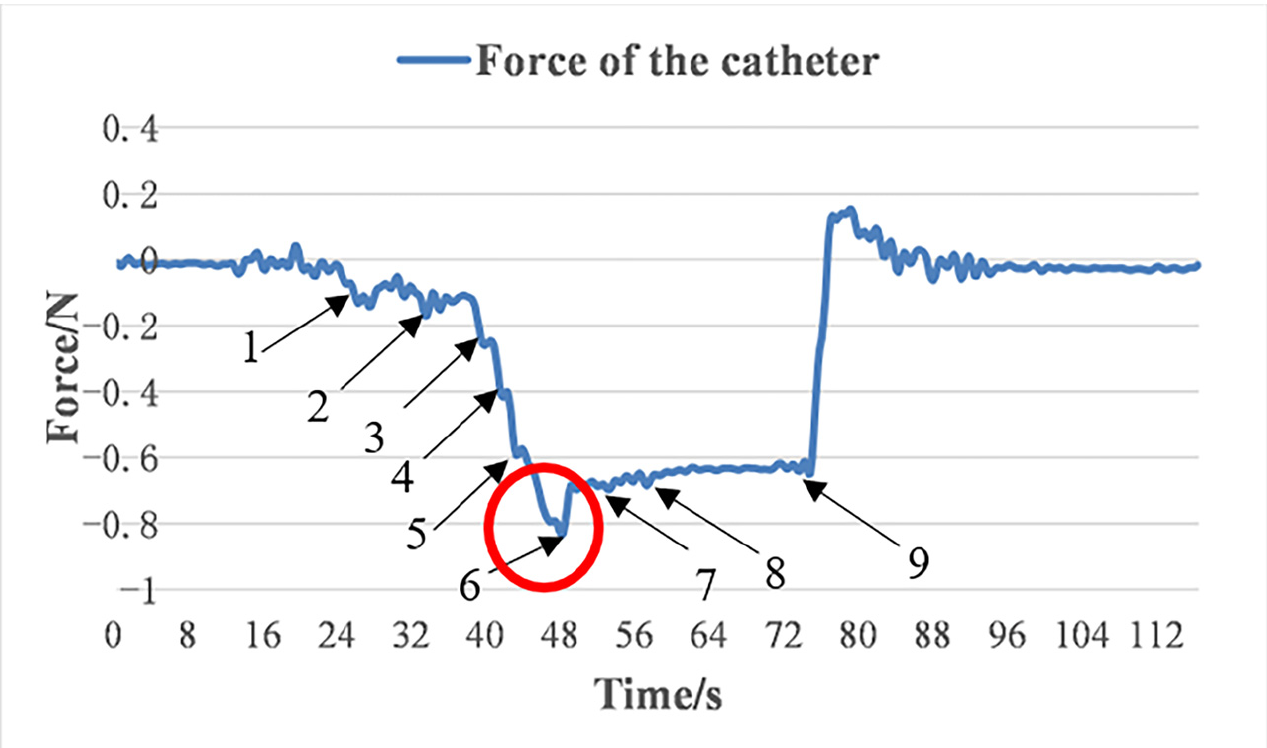
Figure 17. The force of the catheter under condition 1.